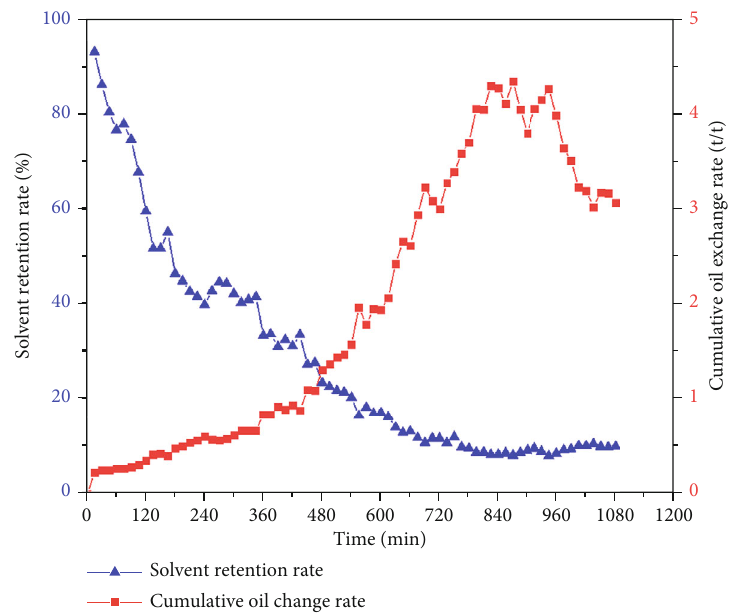
Figure 8: Change in solvent retention e ffi ciency and cumulative oil exchange rate with time in Experiment